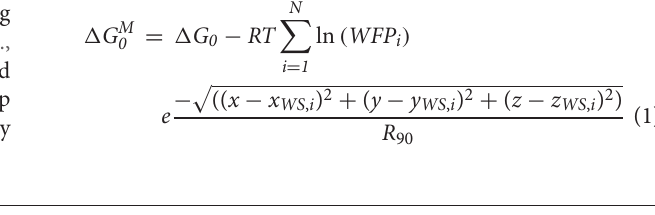
Frontiers in Chemistry |